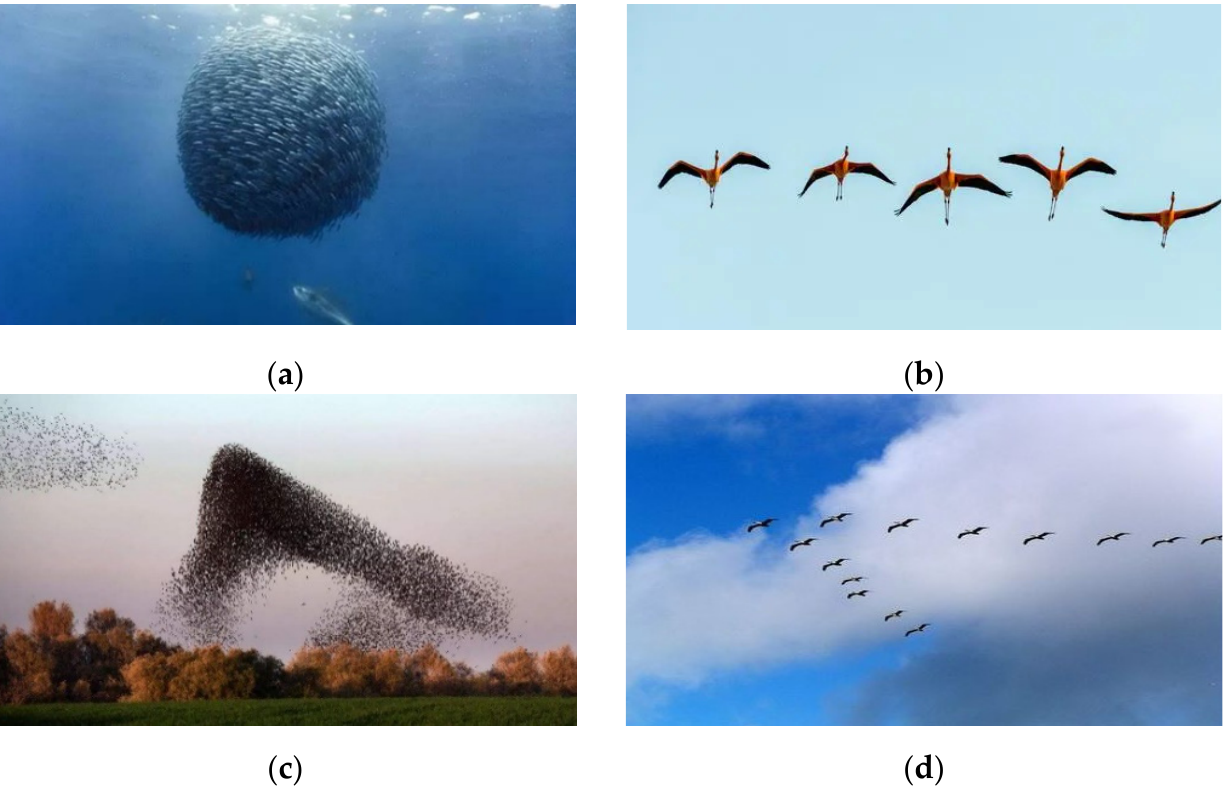
Figure 1. Example of multi-robot cooperation in nature: ( a ) defense strategy of fish school; ( b ) migration of flamingo; ( c ) when sandpipers are frightened; ( d ) migration of geese.